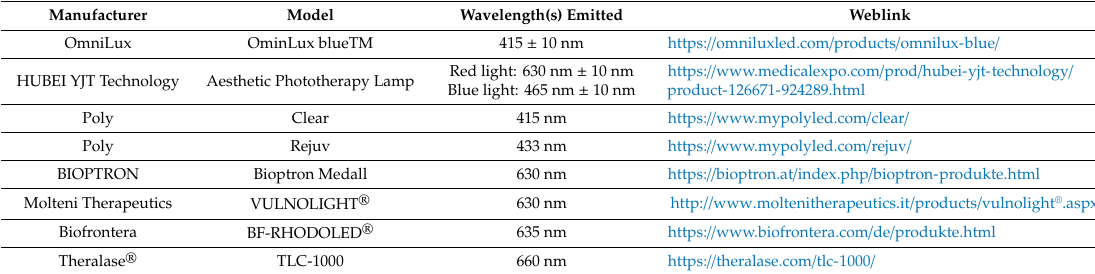
Table 1. Commercially-available LED-based lamps.